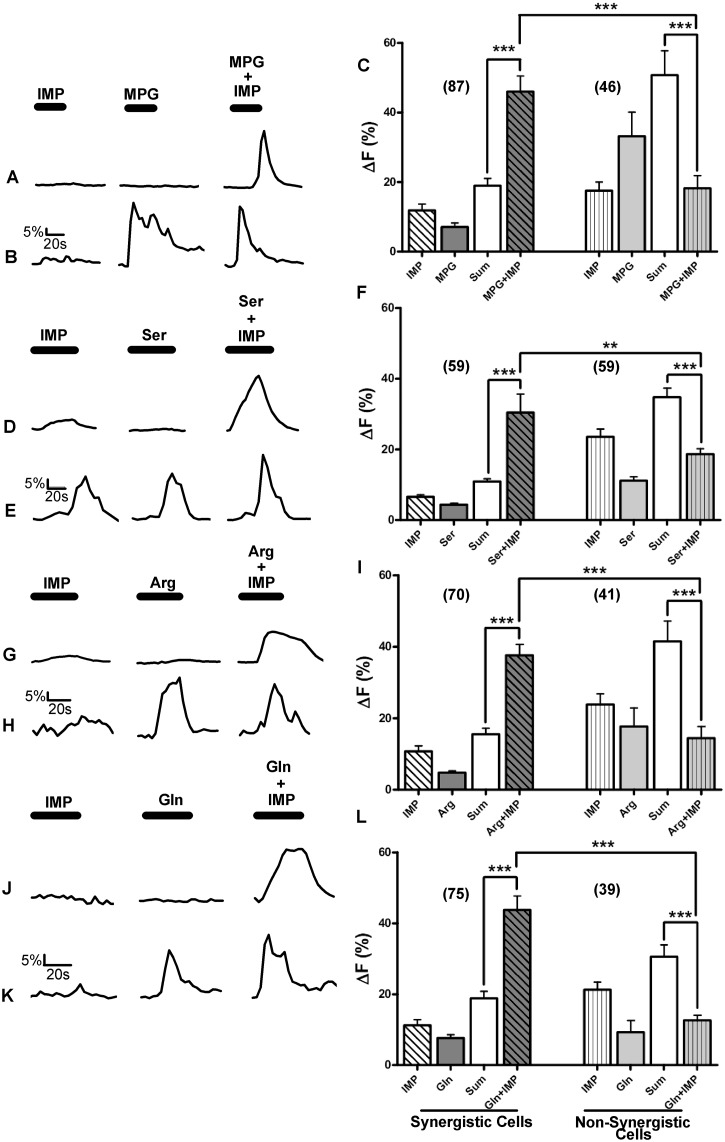
Some but not all TSCs generated synergistic response to the L-amino acid+IMP MIXes.Ca2+ responses of WT TSCs to the four L-amino acid sets are shown. Each L-amino acid set consisted of one of the four different L-amino acids (MPG (10mM), Ser (20mM), Arg (10mM), or Gln (10mM), respectively), IMP (1mM), and the MIX of L-amino acid+IMP. [A, D, G, J] Representative TSC responses where the magnitudes of MIX responses were greater than the summation of individual L-amino acid and IMP responses, i.e., the MIX responses were synergistic. [B, E, H, I] Representative TSC responses where the magnitudes of MIX responses were greater than or equal to the responses of the L-amino acid or IMP individually, but not greater than the summation of individual L-amino acid and IMP responses, i.e., the MIX responses were not synergistic. [C, F, I, L] A Mean±SEM response for the L-amino acid sets exhibiting synergistic and non-synergistic responses. For each L-amino acid set, the MIX responses generated by synergistic cells were significantly greater than the calculated sum (Sum) of L-amino acid and IMP responses. For non-synergistic cells, MIX responses were significantly smaller than the calculated sums of responses to L-amino acid and IMP. MIX responses of synergistic cells were also significantly greater than the MIX responses of non-synergistic cells. Numbers in parenthesis are the number of cells. One-way ANOVA followed by Bonferroni post hoc tests were used for statistical comparisons. ***P<0.0001, **P<0.001.